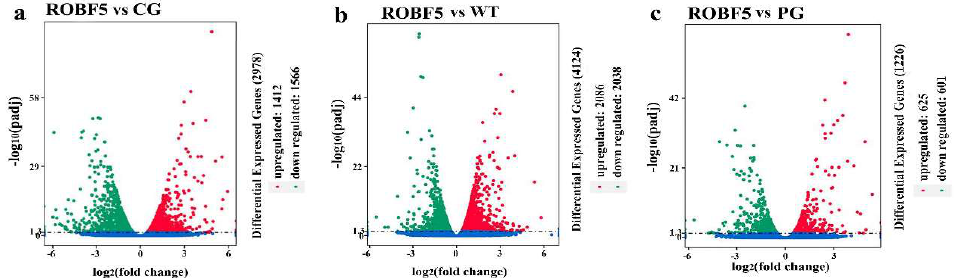
Figure 5. Volcanic map of differential gene expression after treatment of recombinant oil body expressing hFGF5, compared with the treatment of CG, WT and PG. ( a ) ROBF5 vs CG, ( b ) ROBG5 vs WT, ( c ) ROBF5 vs PG. CG: positive control group; WT: wild-type oil body treatment group; PG: hFGF5 treatment group; ROBF5: recombinant oil body expressing hFGF5 treatment group.